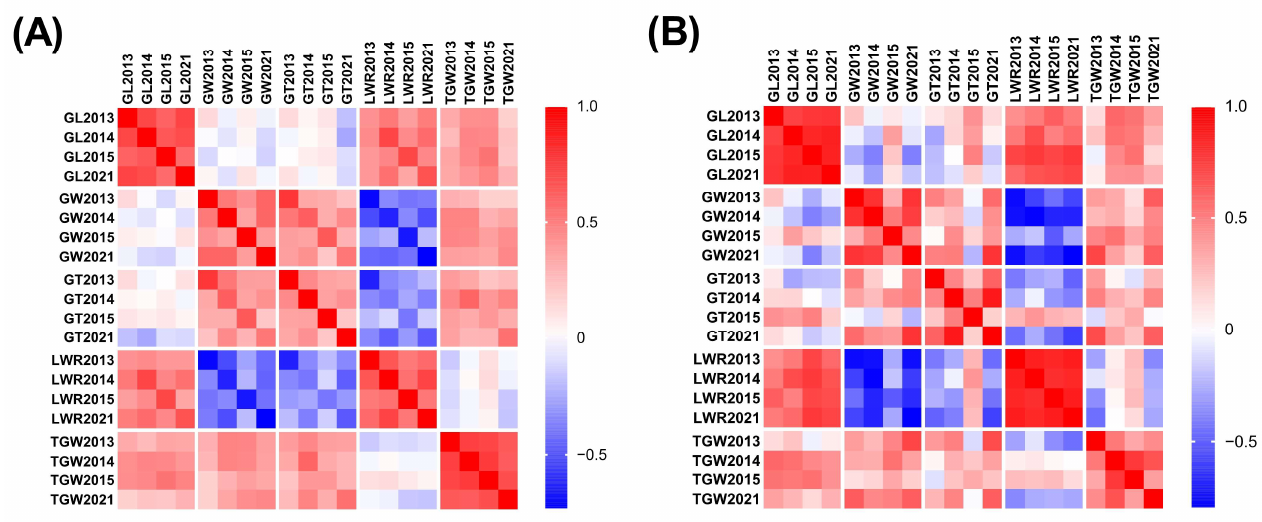
Figure 3. Correlation heatmaps for the indica group ( A ) and the japonica group ( B ) for five grain traits in 2013, 2014, 2015, and